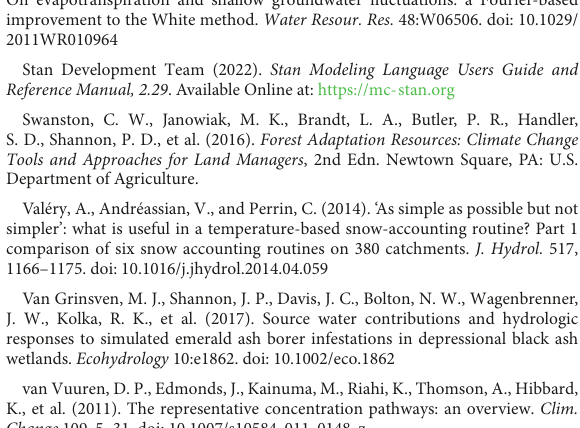
table oscillations. Ecohydrology 10:e1834. doi: